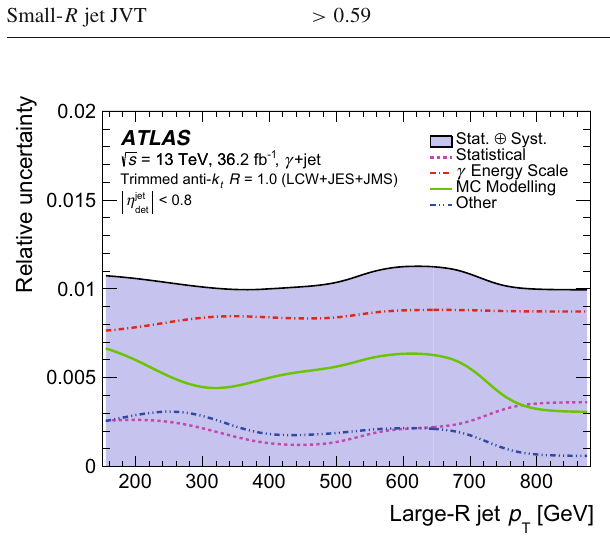
Fig. 11 Systematic uncertainties in the in situ measurement of the jet energyscaleobtainedwiththe γ +jetmethodasafunctionofthelarge- R jet transverse momentum p T . The lines shown are obtained by smooth- ing a binned representation of these uncertainties using a sliding Gaus- sian kernel (MJB) method takes advantage of events where an energetic large- R jet is balanced against a system that consists of mul- tiple lower- p T jets.